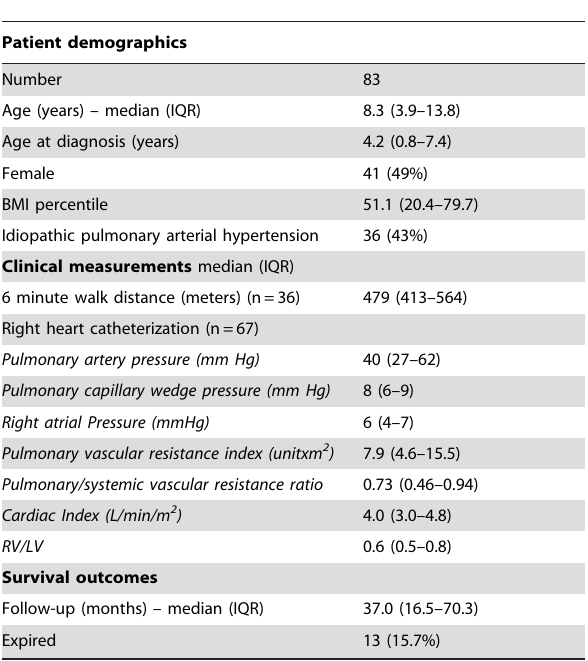
Table 2. Patient demographics and clinical